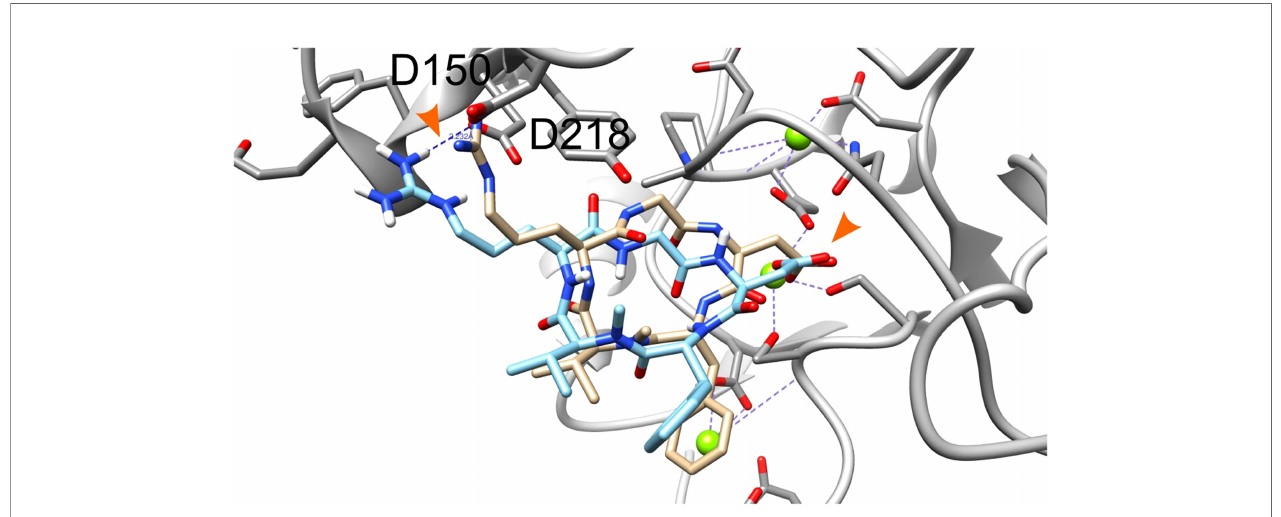
FIGURE 1 | Docking of the cyclic pentapeptide ligand Arg-Gly-Asp-[D-Phe]-[N-methyl-Val-] to integrin a V b 3. Integrin ’ s binding site backbone (ribbons) and side chains (sticks) are colored gray with oxygen atoms in red and nitrogen in blue. The crystallography and docked structures of the cyclic peptide Arg-Gly-Asp-[D-Phe]- [ N-methyl -Val-] are shown using stick representations with carbon atoms colored gold and cyan, respectively. Oxygen, nitrogen, and hydrogen atoms are colored red, blue and white, respectively. Mg 2+ atoms are shown as green spheres. Ligand side chains Arg and Asp are marked with orange arrowhead.